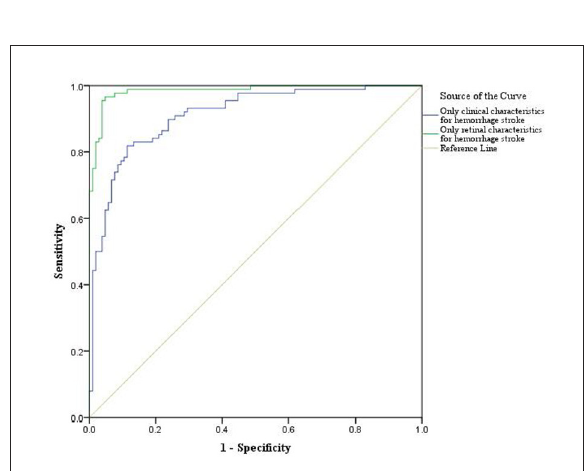
FIGURE3 ROC curves of the model using only clinical characteristics and model using only retinal characterisitcs for haemorrhagic stroke risk estimation.